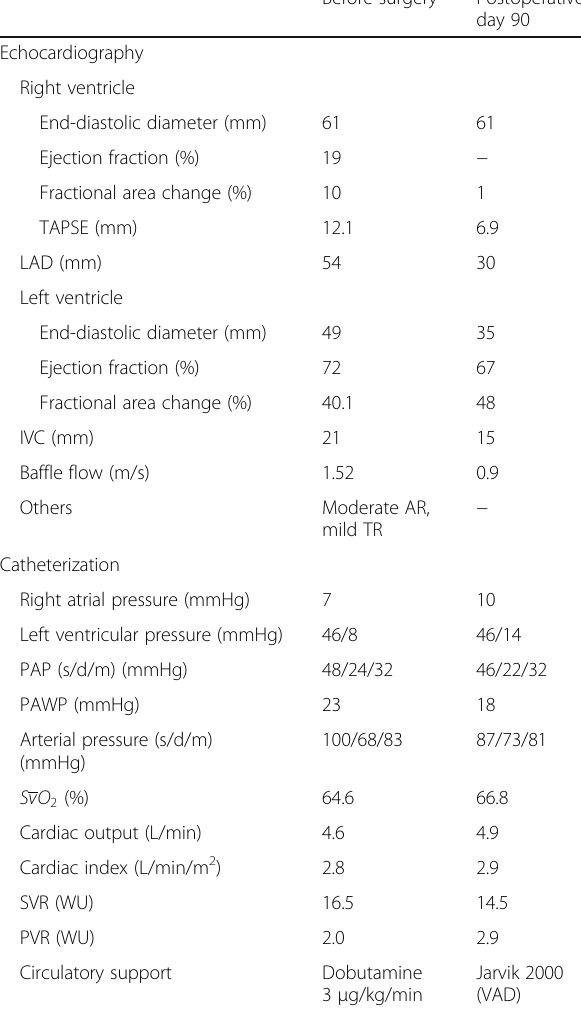
Before surgery Postoperative day 90